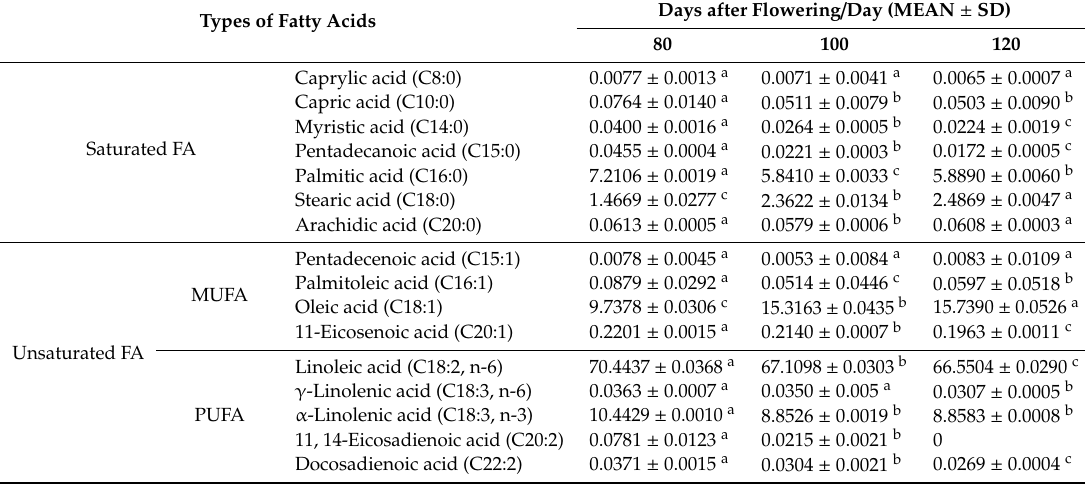
Table 1. Changes of FA composition in walnut kernel oil of 80th, 100th, 120th DAF